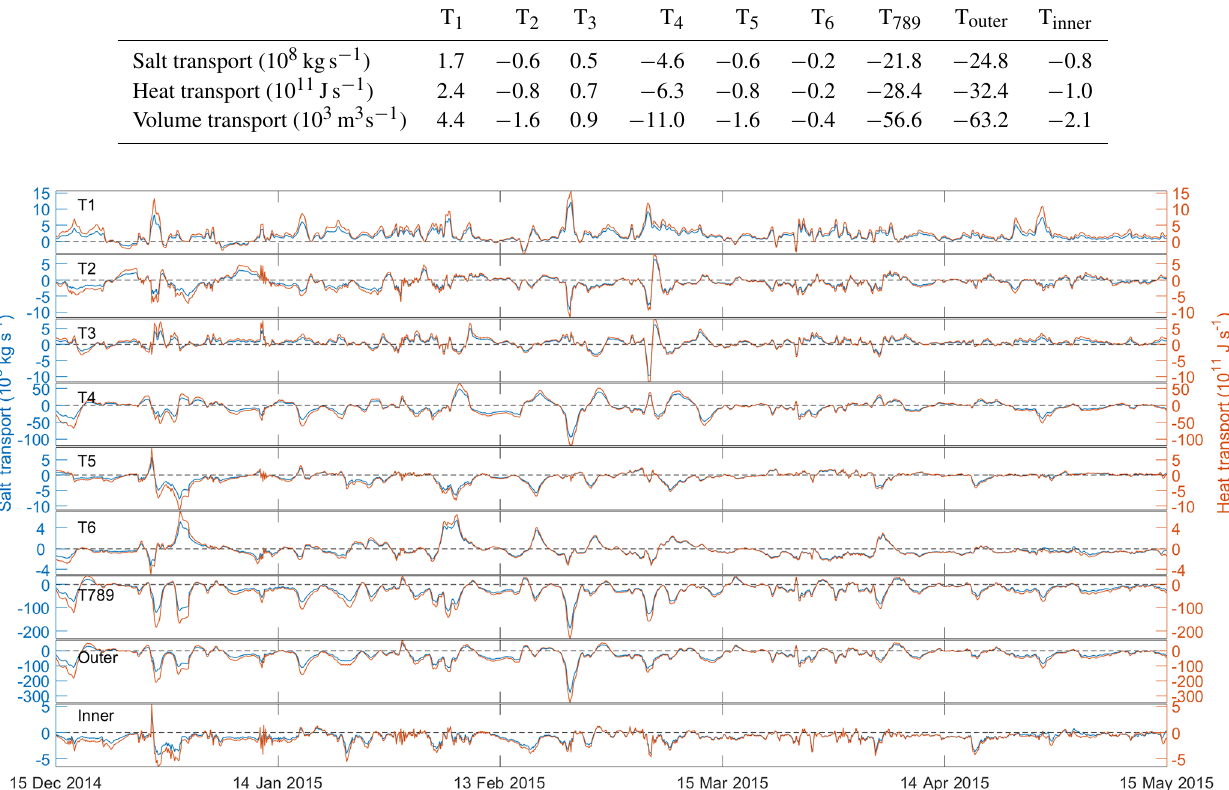
which is also supported by the profiling float data (Fig.